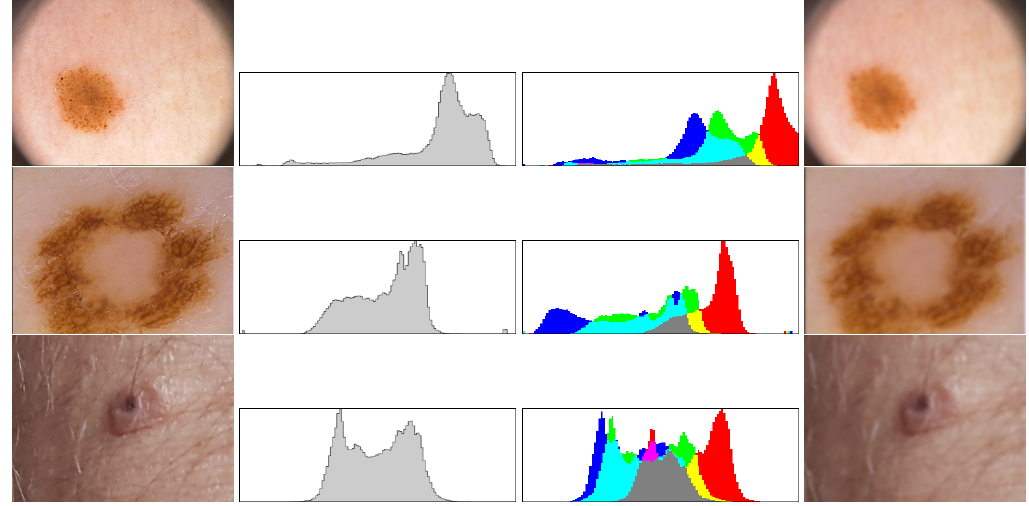
Figure 5. Each cluster is analyzed by the use of histograms (in gray and full color), which are compared to other images stored in the data base system before blurring operation. In the rows 1–3 we see examples of suspicious nevi, both histograms and blurred cluster that will be forwarded to evaluation phase.